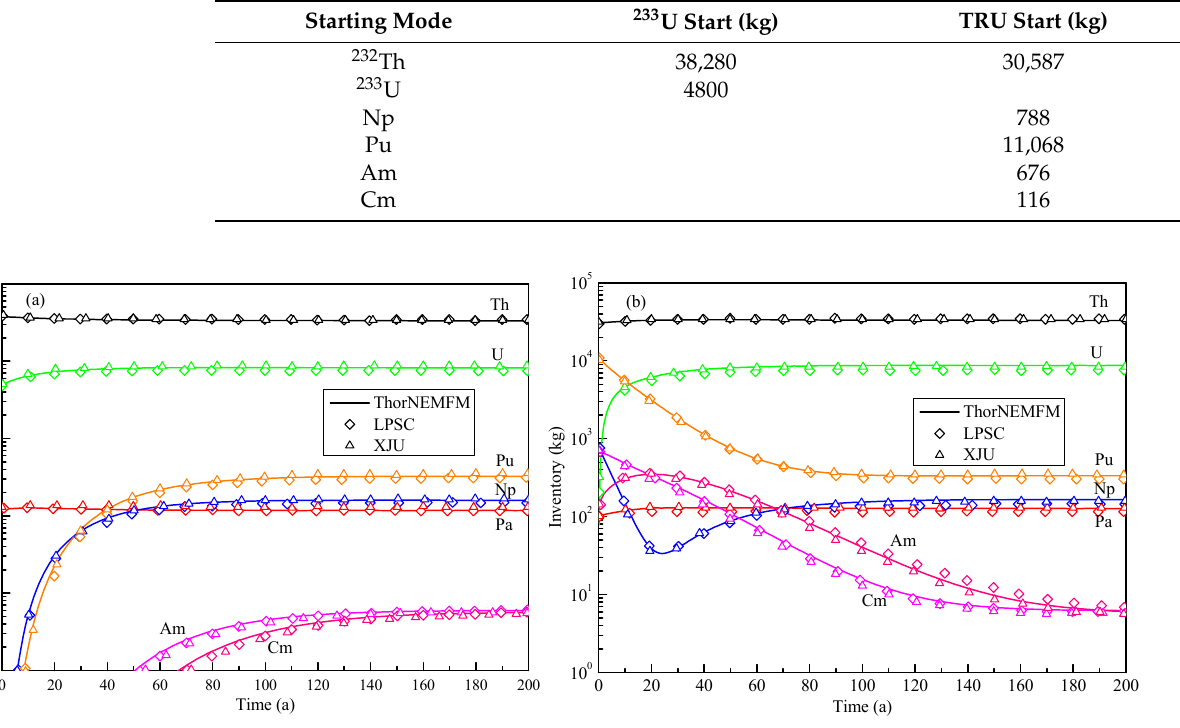
Figure 6. Time evolution of the heavy element inventory for the MSFR: ( a ) 233 U-started and ( b ) TRU-started. Table 5. Inventories of heavy nuclei at equilibrium state in a 233 U-started MSFR in kg.